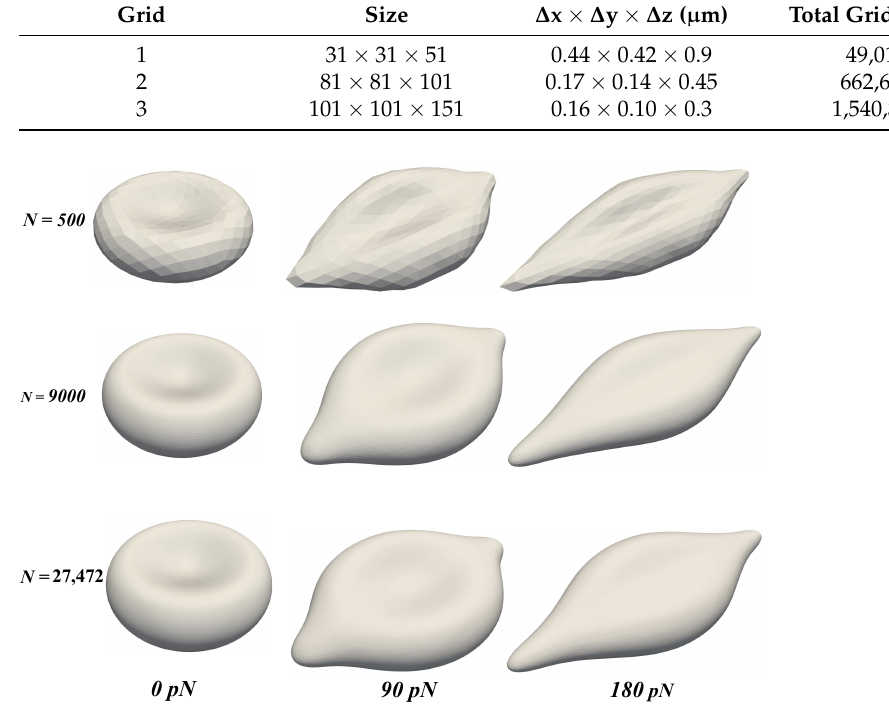
Figure 5. The deformation of the RBC membrane under the stretching force F with different values of N v : 500 (top row), 9000 (middle row), and 27,472 (bottom row). Three time instants (see Figure 3) are chosen to demonstrate the dynamics: 0 pN (left column), 90 pN (middle column), and 180 pN (right